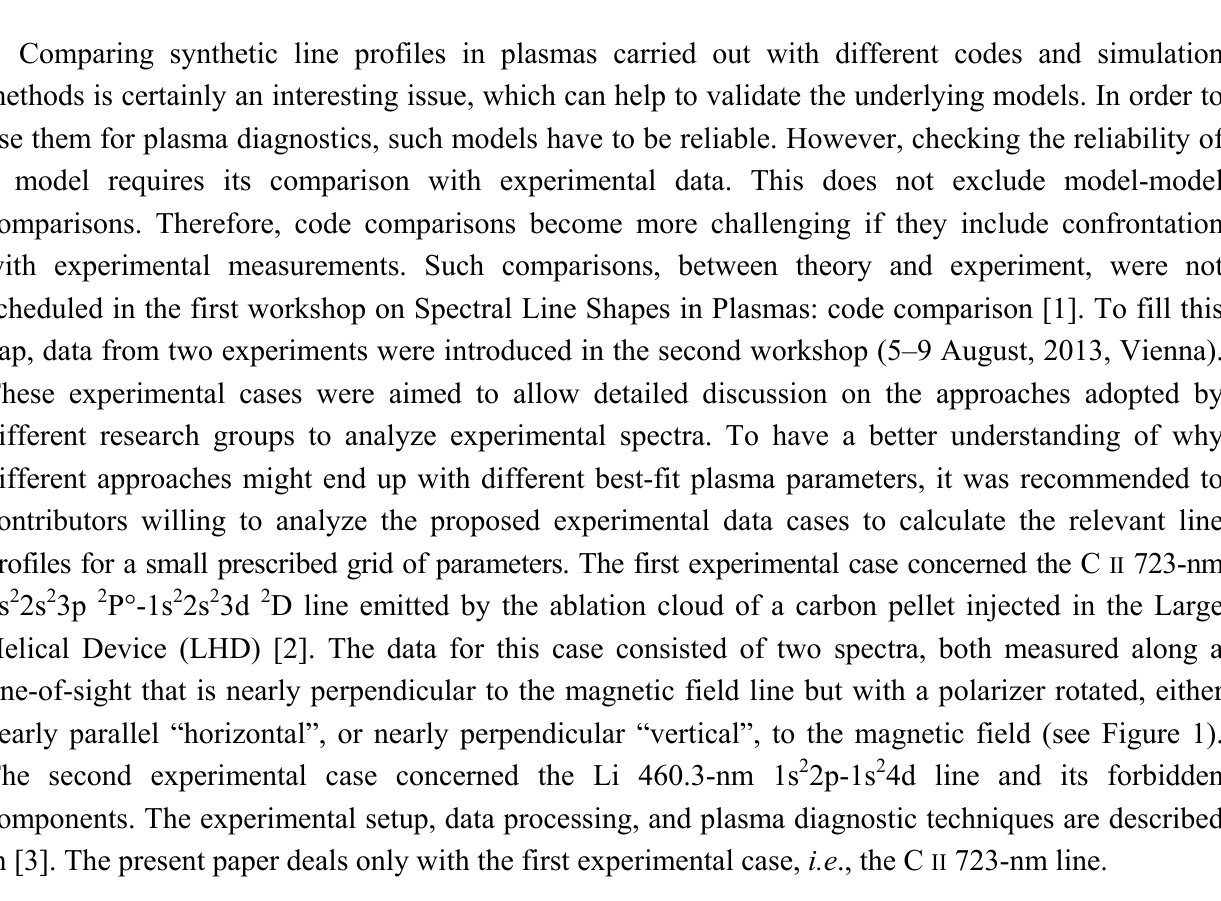
Figure 1. Geometry of observations for the experimental spectra of the C II 723-nm line measured from the ablation cloud of a carbon pellet injected in the stellarator